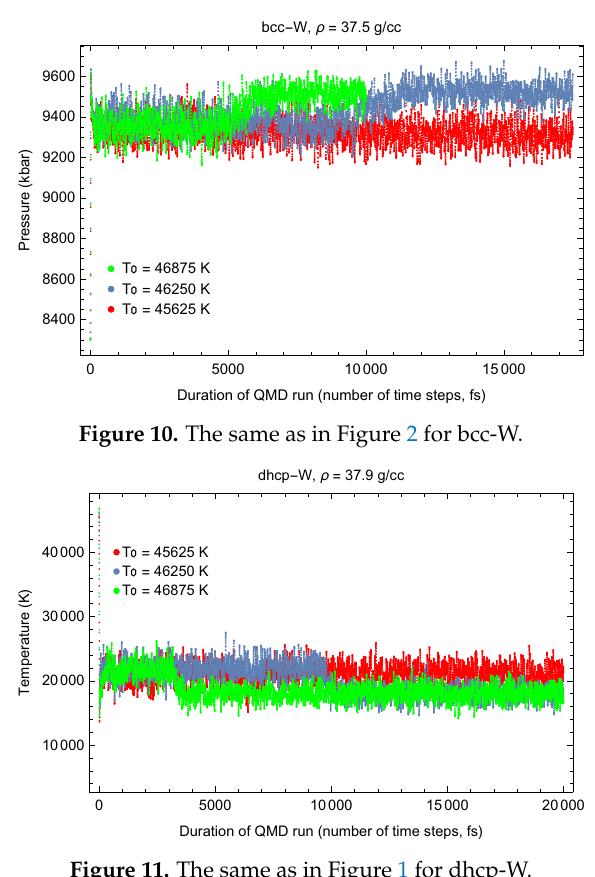
Figure 11. The same as in Figure 1 for dhcp-W.